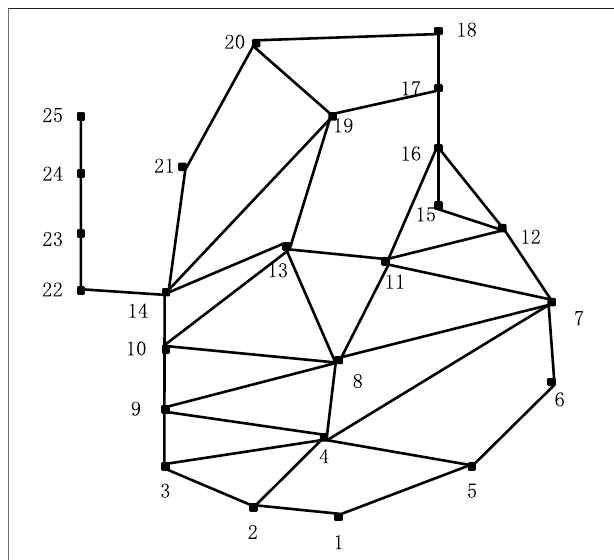
FIGURE 4 | Schematic diagram of the calculation example of the traf fi c system.